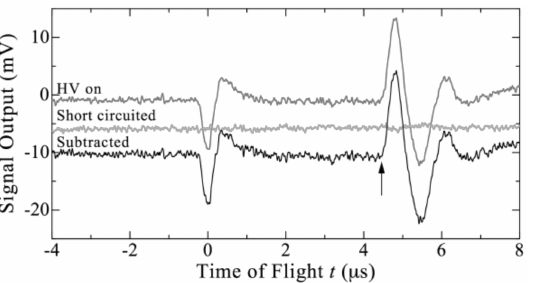
Figure 4. Acoustic waveform examples for voltage-on and -off conditions. The waveforms were vertically shifted to increase visibility. The arrow represents the tail position of the IR used for analysis in Figures 5–7.